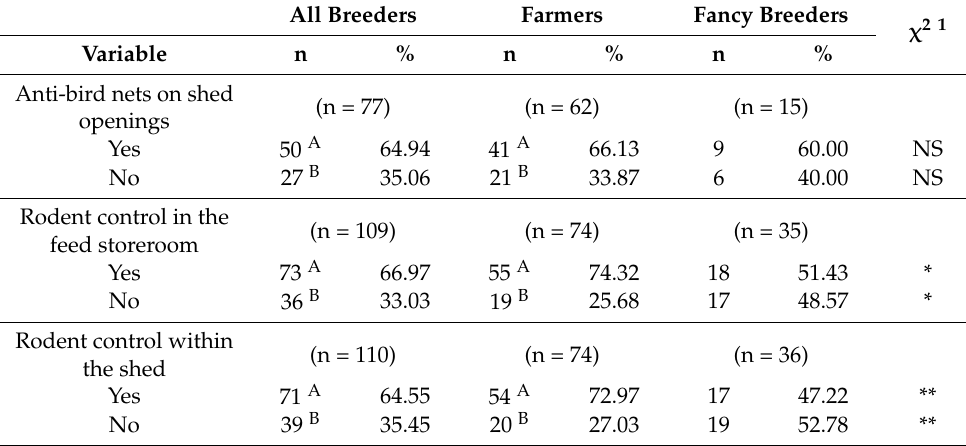
different ( χ 2 -test p < 0.01). Table 13. Vermin control measures implemented: responses from all breeders and divided according to breeder category.